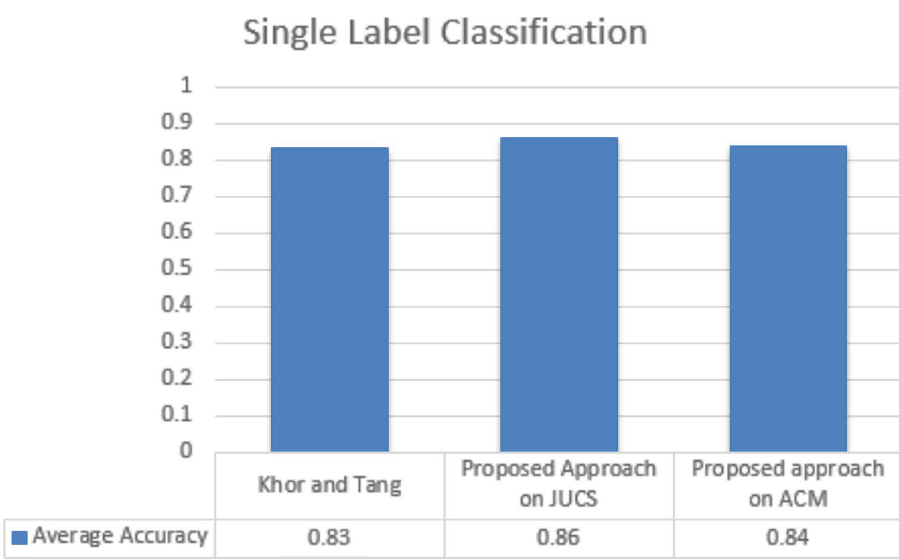
Figure 18. Single label classification